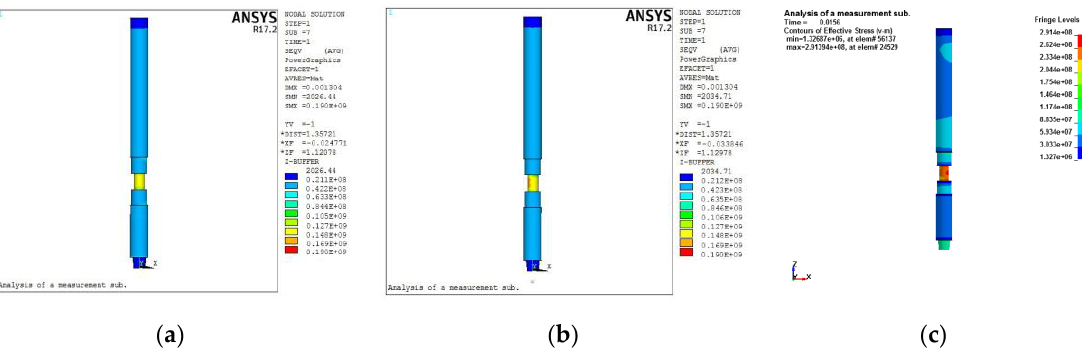
Figure 14. Stage results of the implicit-to-explicit sequential solution: ( a ) implicit solution result; ( b ) initialization model for explicit analysis; ( c ) explicit analysis result.